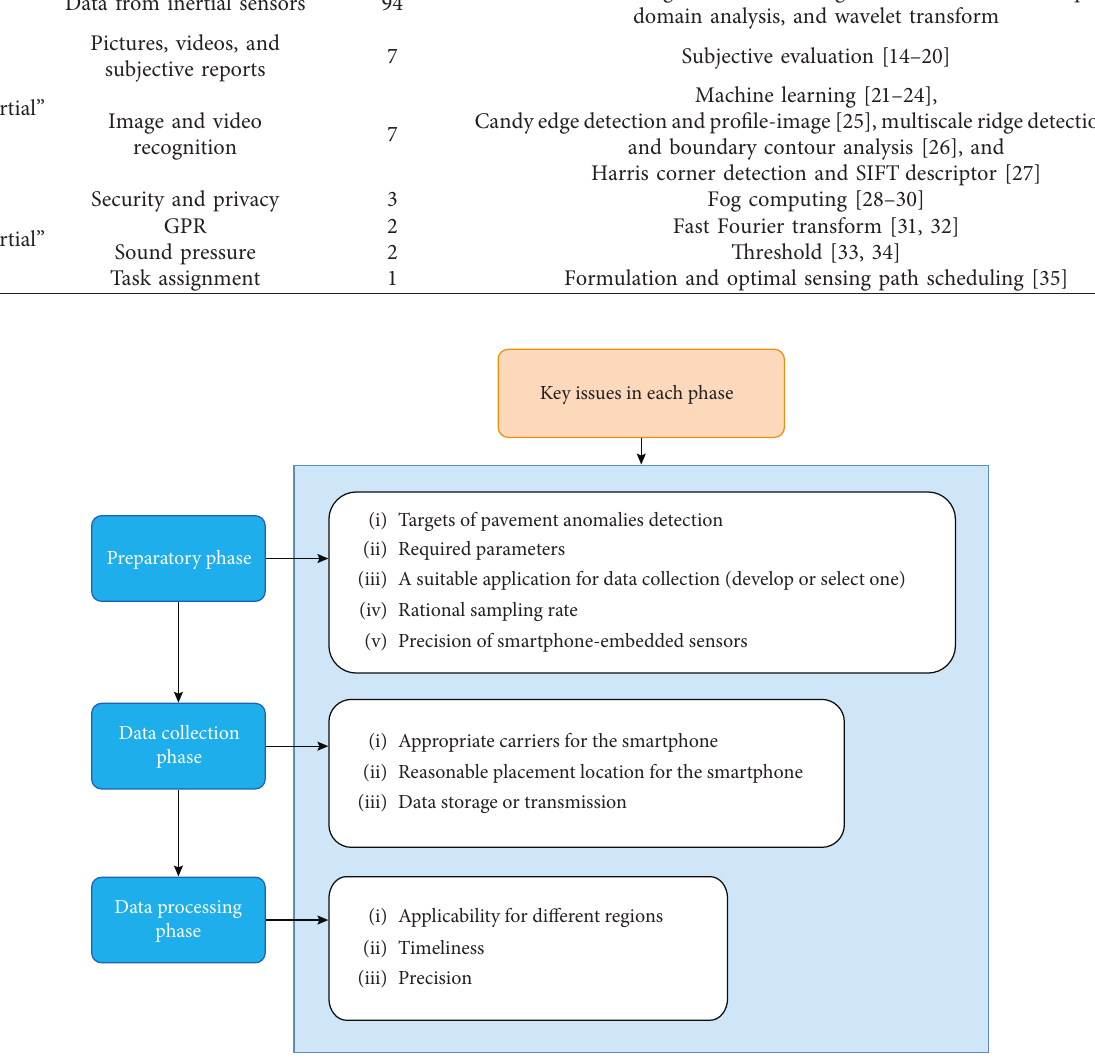
Figure 6: Key issues in each phase of the experiment.